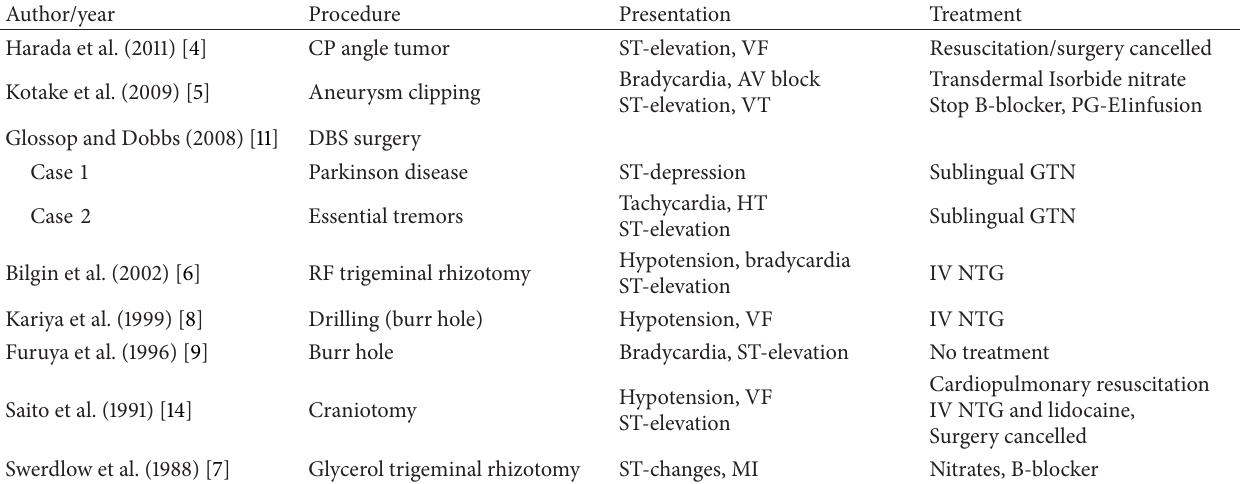
Table 1: Cases related to coronary artery spasm during neurosurgical